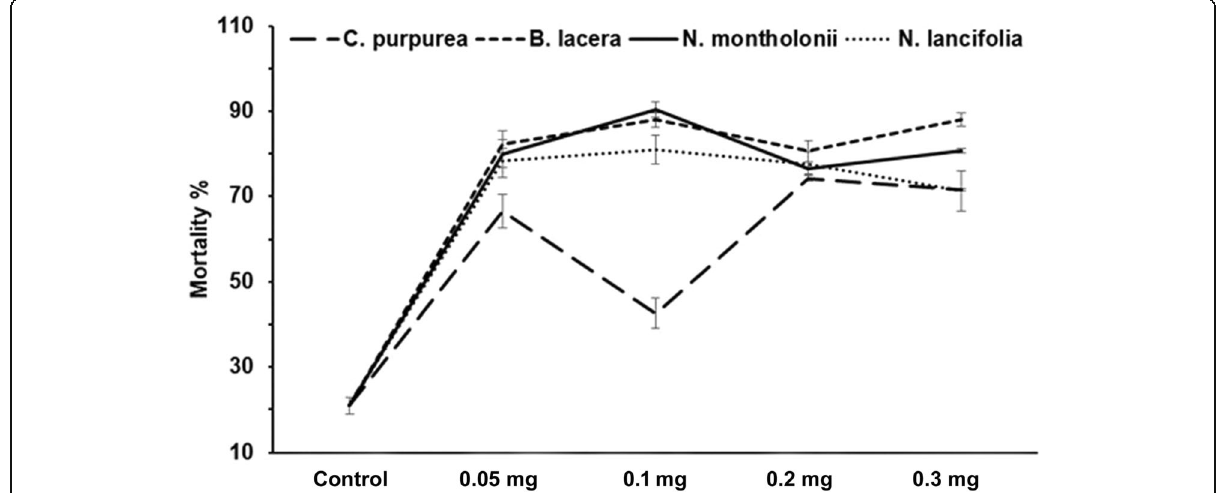
Fig. 2 Ovicidal activity (concentrations vs. mortality) of ethanolic extracts of Cyathocline purpurea , Blumea lacera , Neanotis montholonii , and N.lancifolia in A. aegypti